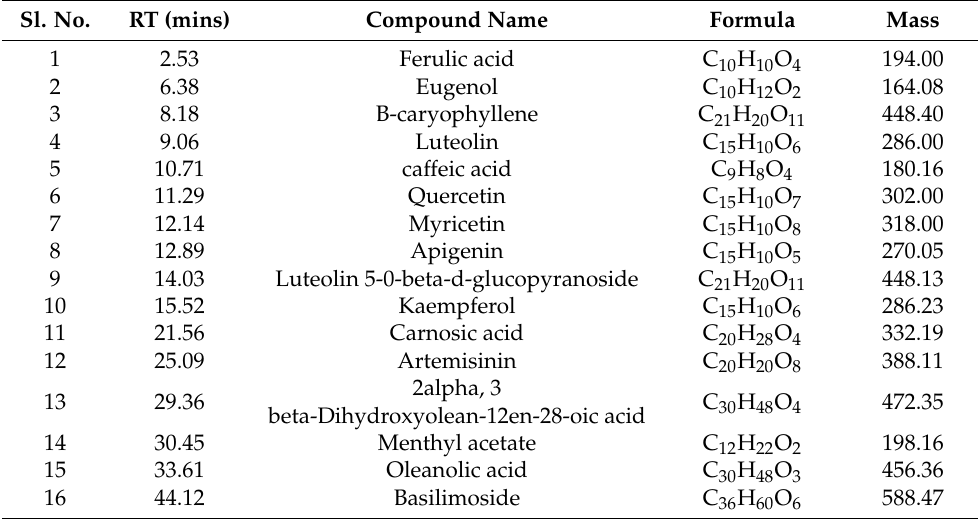
Figure 1. The LC-MS total ion chromatogram of the A. nilagirica extract. Table 3. LCMS profiling of A. nilagirica with the retention time (RT), molecular mass, and chemical formula.